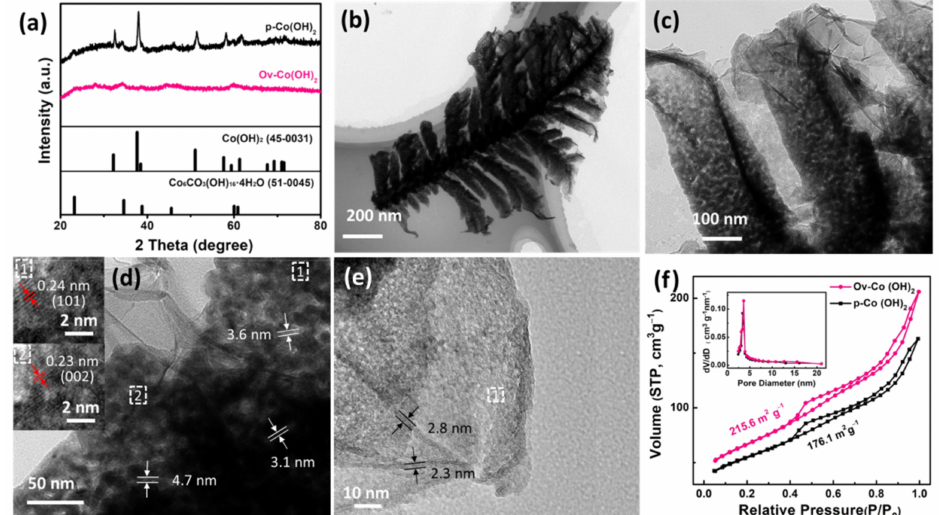
Figure 2. ( a ) X-ray diffraction patterns of p –Co(OH) 2 and O V − Co(OH) 2 ; ( b , c ) transmission electron microscopy images of O V − Co(OH) 2 ; ( d ) high-resolution transmission electron microscopy (HRTEM) images of the dendrite section of O V − Co(OH) 2 ; ( e ) HRTEM images of the covered nanoflakes of O V − Co(OH) 2 ; ( f ) N 2 adsorption and desorption isotherms and the corresponding pore size distribution (inset) of O V − Co(OH) 2 and p − Co(OH) 2